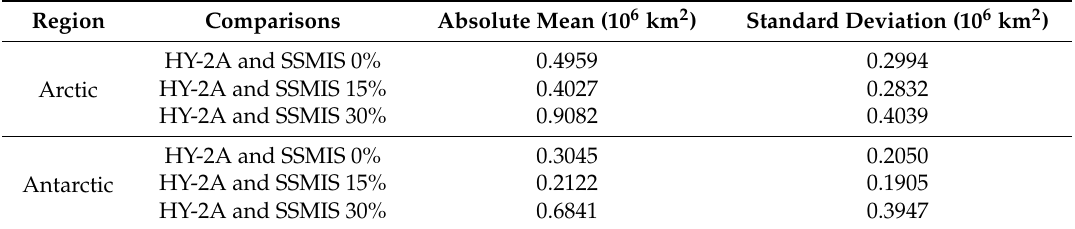
Figure 6. The HY-2A/SCAT and SSMIS 0%, 15% and 30% sea ice extents from January 2013 to July 2015. Table 1. Statistics of the comparisons between HY-2A and SSMIS 0%, 15% and 30% sea ice extents.